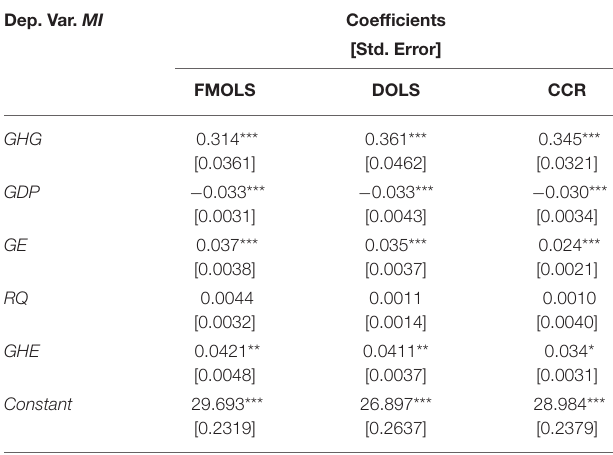
TABLE 6 | Empirical results of empirical model. Dep. Var.